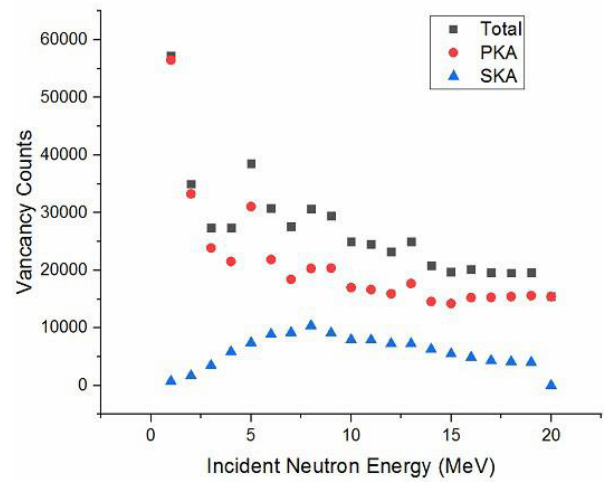
Figure 11. Relationship between the energy of neutrons and the number of defects.